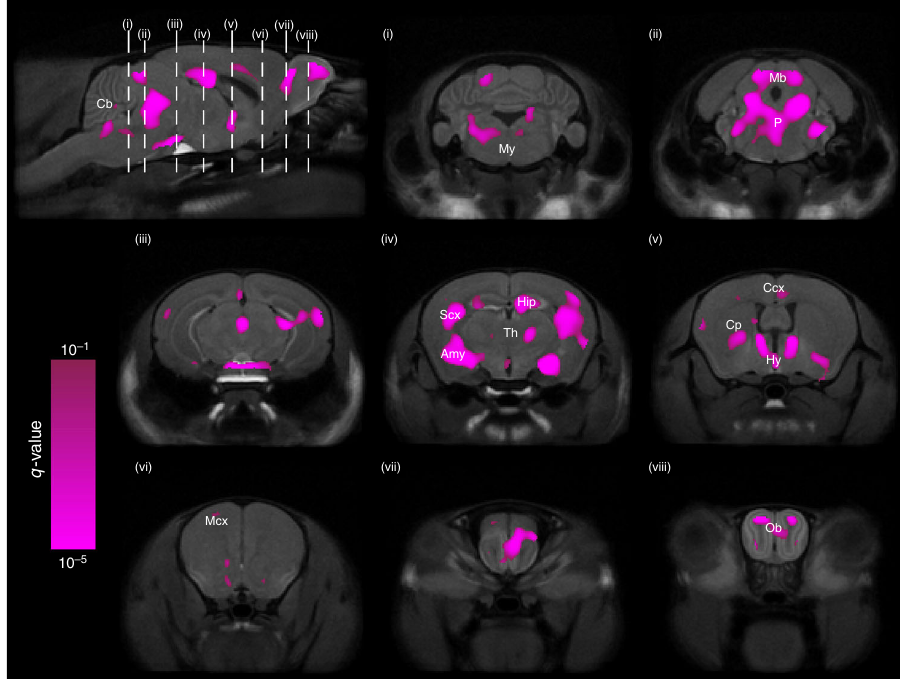
Fig. 4 Sexually dimorphic neuroanatomy. Two linear mixed-effects models were fi t to the data: Model 1 had sex as a predictor and Model 2 did not. Every voxel was assessed on whether Model 1 had a signi fi cantly better fi t than Model 2. The resulting q-values (thresholded to q<0.1) were overlaid on p65 average brain cross-sections, identifying several regions in the brain where volumes are signi fi cantly dependent on sex. These sexually dimorphic regions include parts of the cerebellum (Cb), medulla (My), midbrain (Mb), pons (P), PAG, thalamus (Th), hippocampus (Hip), amygdala (Amy), sensory cortex (SCx), hypothalamus (Hy), cingulate cortex (Ccx), caudoputamen (Cp), BNST, motor cortex (Mcx), and olfactory bulbs